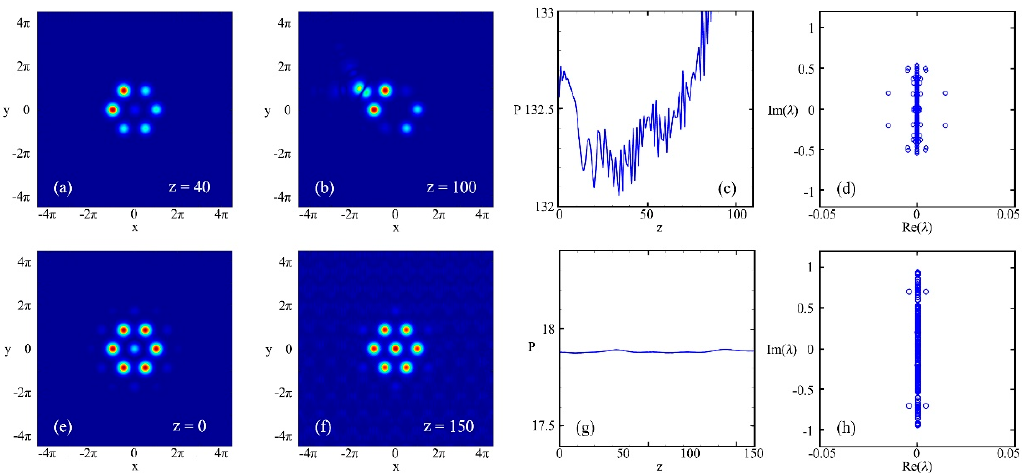
Figure 9. The dynamics of strongly nonlocal six-pole solitons. The first row corresponds to the unstable soliton with d = 2, µ = 8.4, and the second row corresponds to the stable soliton with d = 2, µ = 10.4. ( a , b , e , f ) show their transverse profiles. ( c , g ) show the power of the soliton, P , during propagation. ( d , h ) show the spectrums of their perturbation growth rates.